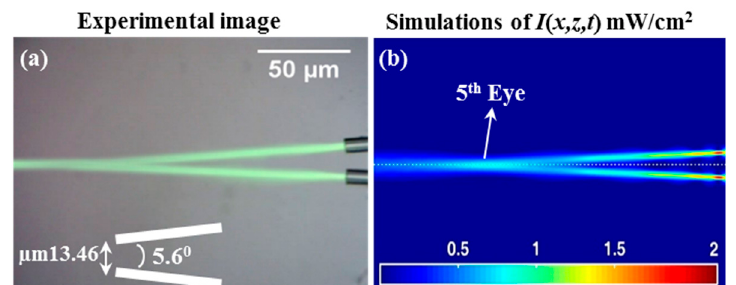
Figure 8. ( a ) Experimental observation image and ( b ) simulated light beam intensity, I ( x,z,t ) mW/cm 2 . Self-bending SWW behaviors for t exp = 1600 s of λ = 532 nm and P 0 = 0.1 mW (i.e., each fiber has P 0 = 0.1 mW). Two fibers initially separated by 13.46 μ m and an angle of 5.6°. The formation of a Y -coupler ( Y -waveguide). In all cases, the beams travel from right to left.